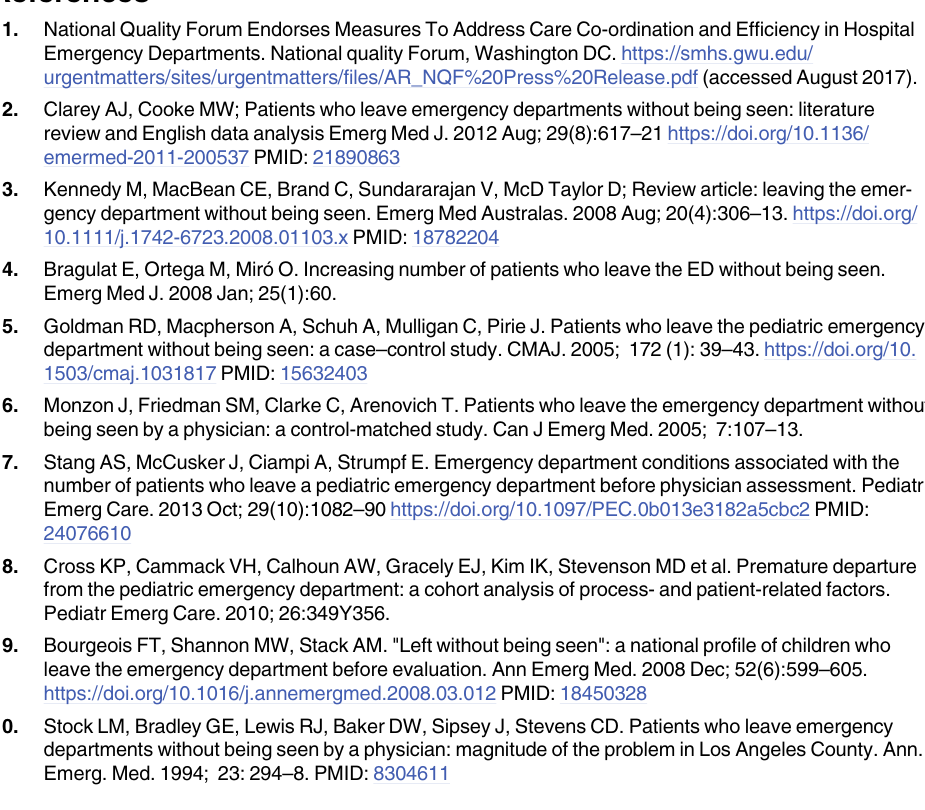
S1 Table. ICD9-CM codes for identification of chronic comorbidities or diagnosis that could cause a post-acute